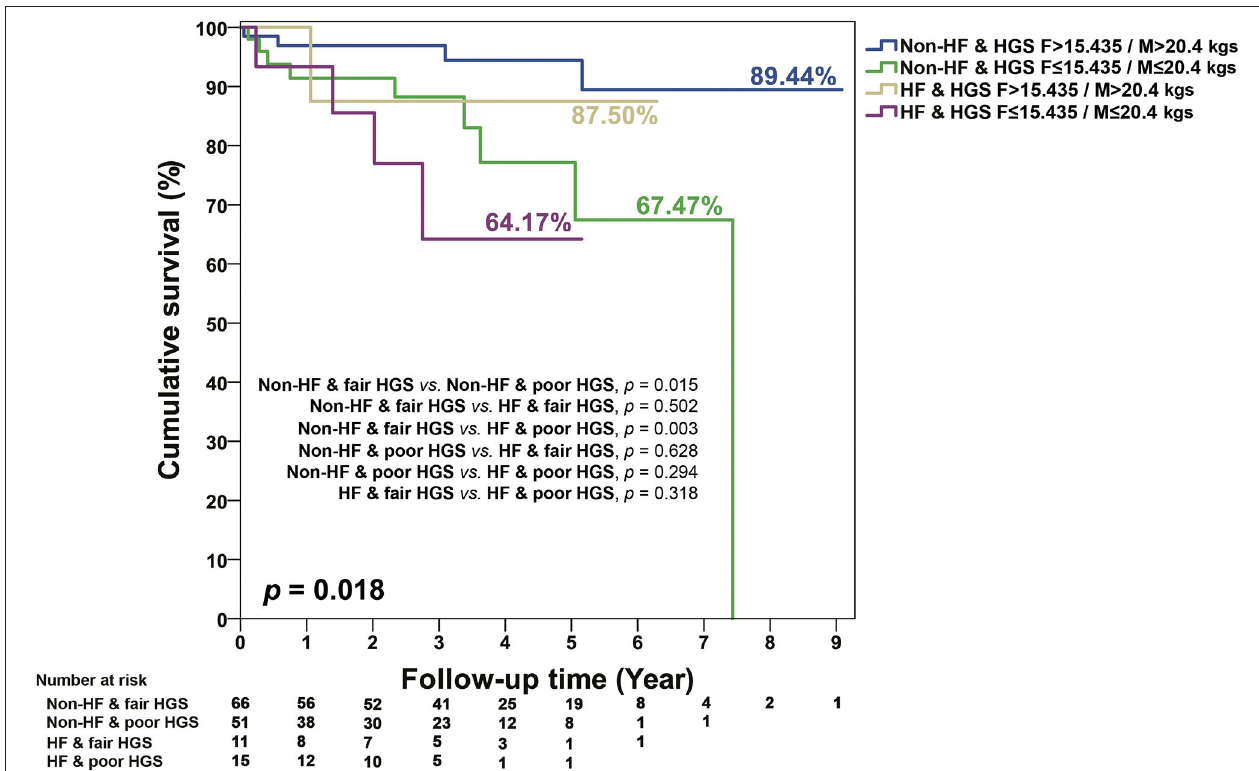
FIGURE 1 | KM survival curves for mortality stratified by the different levels of HGS, HF, and non-HF. Poor HGS in females ≤ 15.435 kg/males ≤ 20.4kg; fair HGS in females > 15.435 kg/males > 20.4kg.